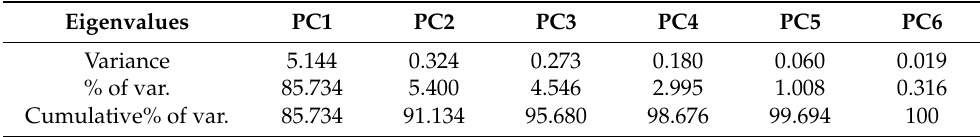
Table 7. The eigenvalues of the correlation matrix (20 m/s). Eigenvalues Table 6. The eigenvalues of the correlation matrix (15 m/s).